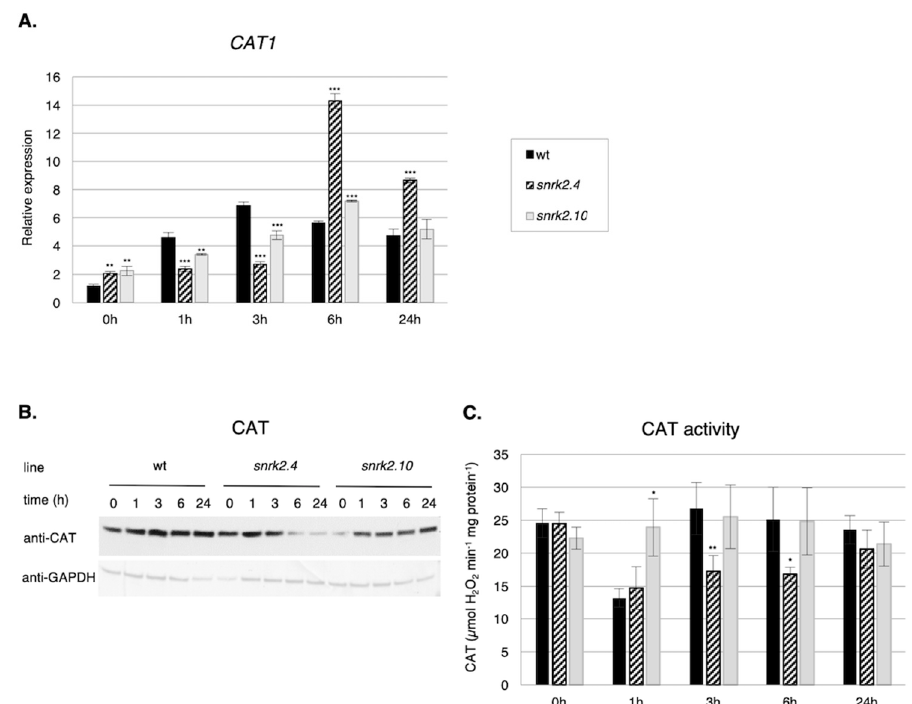
Figure 3. SnRK2.4 and SnRK2.10 modulate catalase (CAT) on multiple levels during response to salt stress. Wild type and snrk2 mutants’ seedlings were subjected to treatment with 150 mM NaCl for times indicated. CAT1 expression was determined by RT-qPCR ( A ), total catalase protein was determined by immunoblot analysis ( B ), and total catalase activity assay was performed ( C ); error bars represent SD; stars represent statistically significant differences in comparison with the wt plants (Student t -test) where * p < 0.05; ** p < 0.001; *** p < 0.0001. After exposure, membranes were stripped and reused for glyceraldehyde 3-phosphate dehydrogenase (GAPDH) detection as a loading control. At least two independent biological replicates of the experiment were performed, each with four samples per data point. Results of one representative experiment are shown.